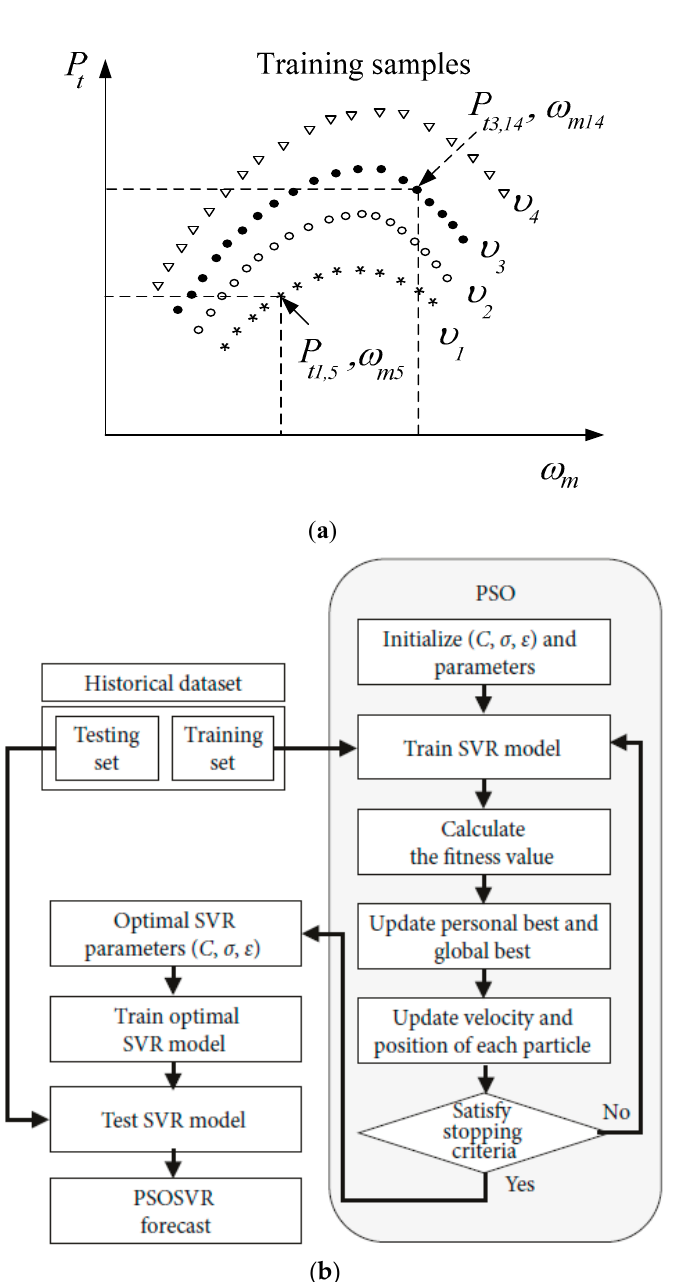
Figure 13. Wind speed estimation process: ( a ) Training samples, ( b ) implementation process diagram.